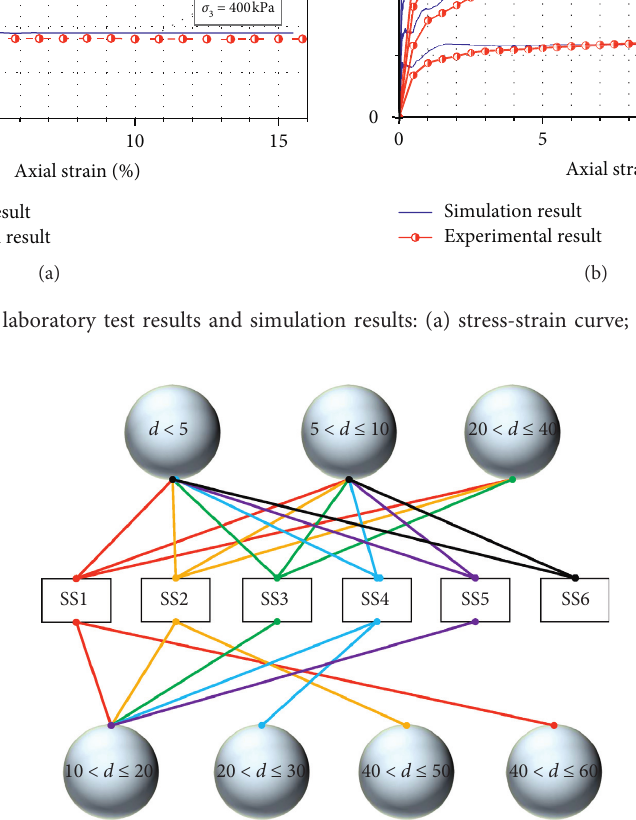
Figure 10: The particle size range of the granule group corresponding to each scheme (unit: